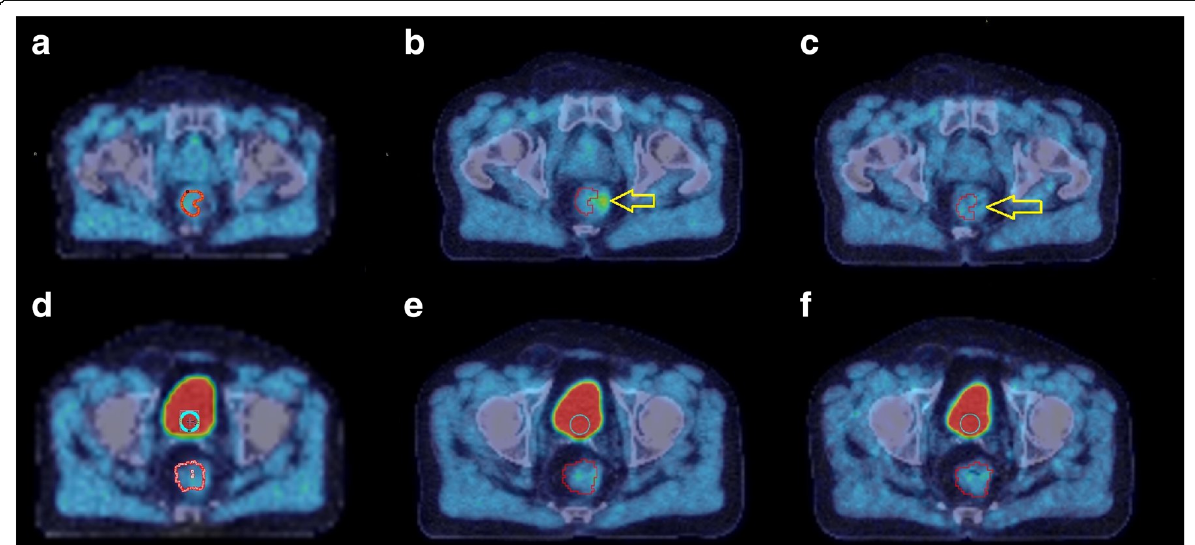
Fig. 6 Example from enema group showing the PET-CT scans at 45 min ( a , d ), 2 h ( b , e ) and 4 h ( c , f ) for different transaxial slices in the same subject. The blue circular ROI of 10 mm radius was drawn on three consecutive slices in bladder, the red ROI marks the tumour and the yellow arrow shows the non-tumour activity in close proximity to the tumour ROI. a – c highlights the fact that the non-tumour [ 18 F]FMISO in rectum in close proximity to the tumour is visible at 2 h, but not after the enema given before the 4 h scan. In d – f , the patient emptied their bladder before the 4 h scan as seen from the reduced volume/activity in the bladder in f compared to d (42 cm 3 compared to 16 cm 3 when thresholded using an absolute value of 5 kBq/cm 3 to estimate the bladder volume) but the activity accumulated again at 4 h (in f ). As a result, the tumour TAC in Fig. 7 shows an increase while the bladder activity was almost the same at 2 and 4 h, showing the direct effect of bladder activity on tumour [ 18 F]FMISO quantification. PET = positron emission tomography; CT = computed tomography; min = minute; h = hour; ROI = region of interest; mm = millimetre; cm 3 = cubic centimetre; TAC = time-activity curves; [ 18 F]FMISO = [ 18 F]fluoromisonidazole; kBq = kilo